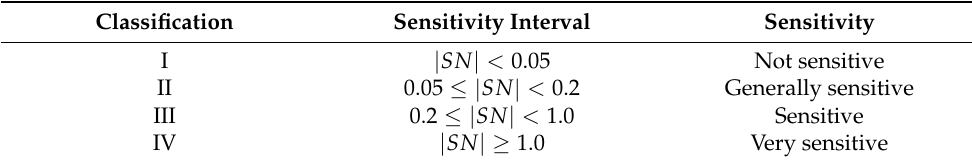
Table 4. Sensitivity classification.